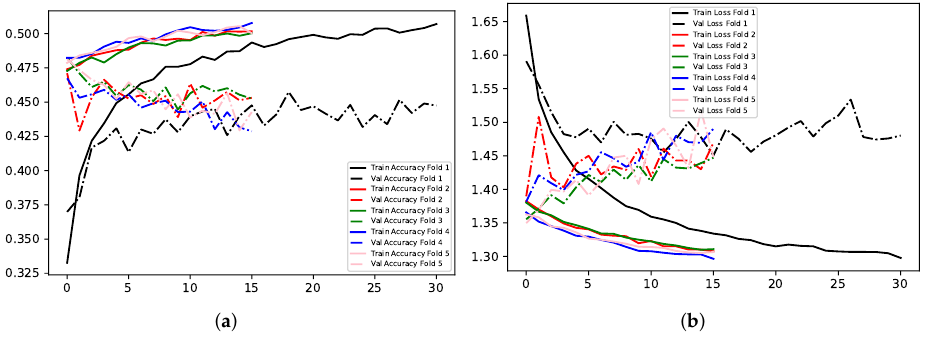
Figure 11. Model A experiment 3 results. ( a ) Accuracy. ( b ) Loss.